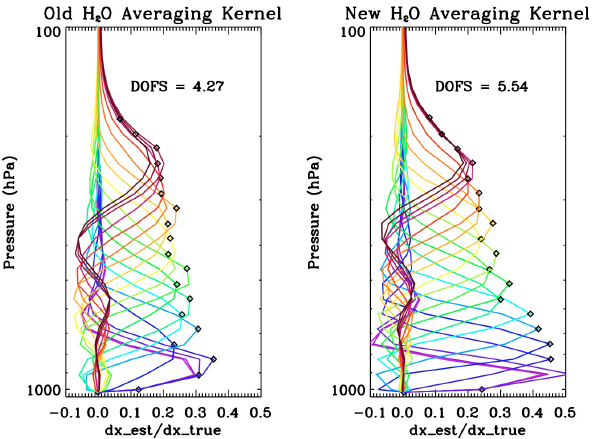
Figure 2a: Averaging kernels for a TES water retrieval using old (spectral windows shown in Figure 2b) and new (using almost all the radiance shown in Figure 2b). The diamonds indicate the pressure level for the averaging kernel. Color coding is to help the reader follow the variability of each averaging kernel with pressure.